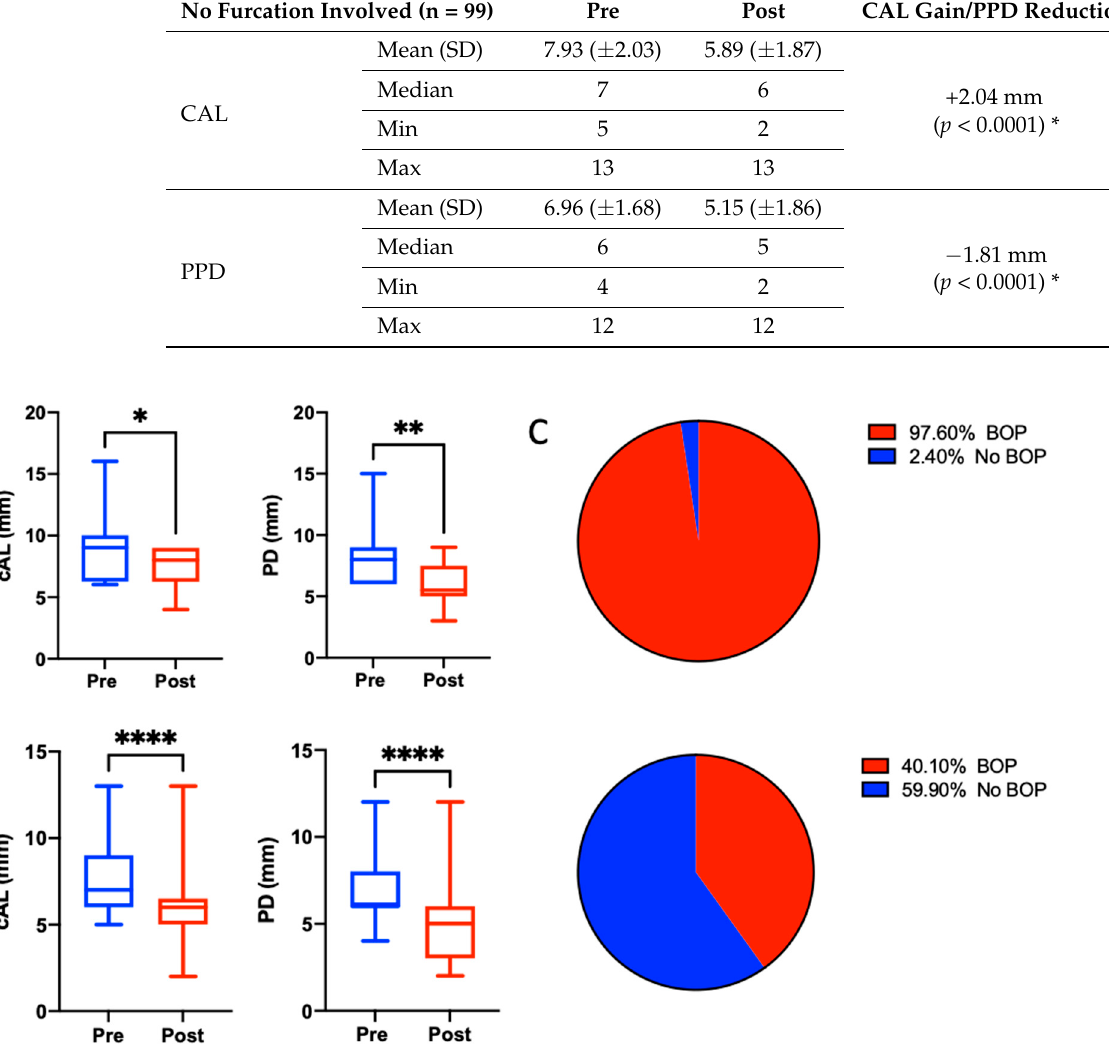
Figure 2. Boxplots for clinical parameters before and after the treatment sequence of non-furcation- involved ( A ) and furcation-involved ( B ) sites. Whiskers represent minimum and maximum values. * p < 0.05, ** p < 0.01, **** p < 0.0001. ( C ) Amount of sites exhibiting bleeding on probing before (upper) and after (lower) the